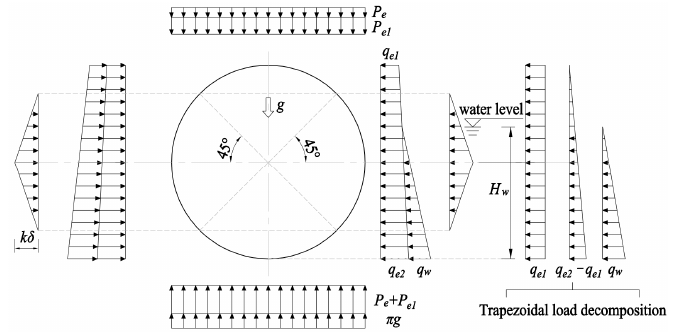
Figure 6. Load acting on segment as water table located within tunnel section.